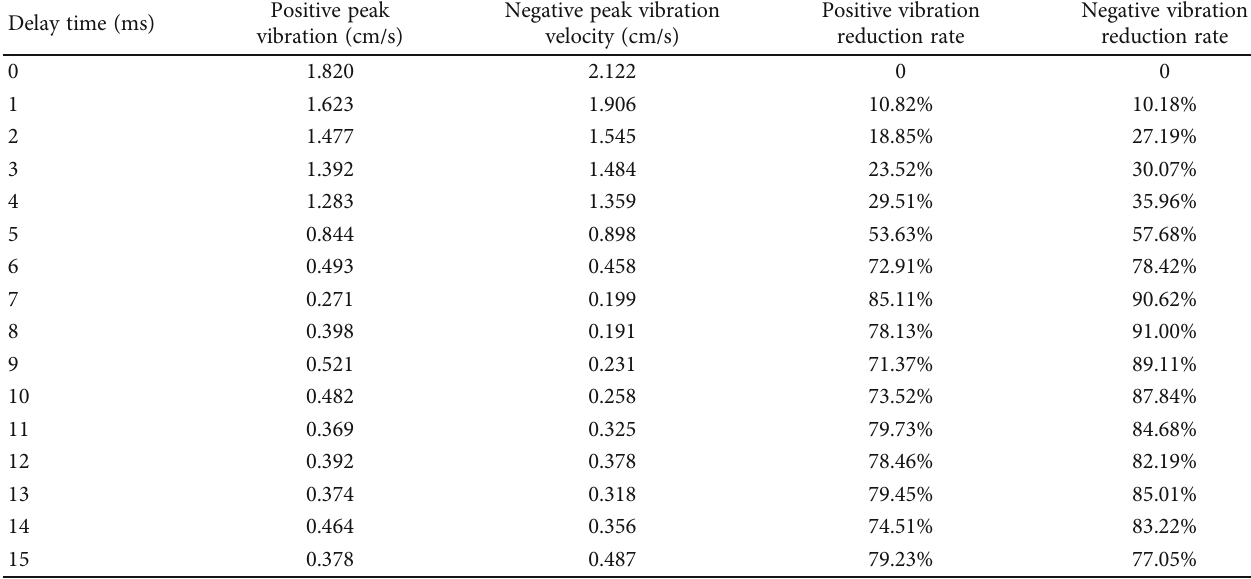
Table 2: Vibration reduction rate under di ff erent delay time